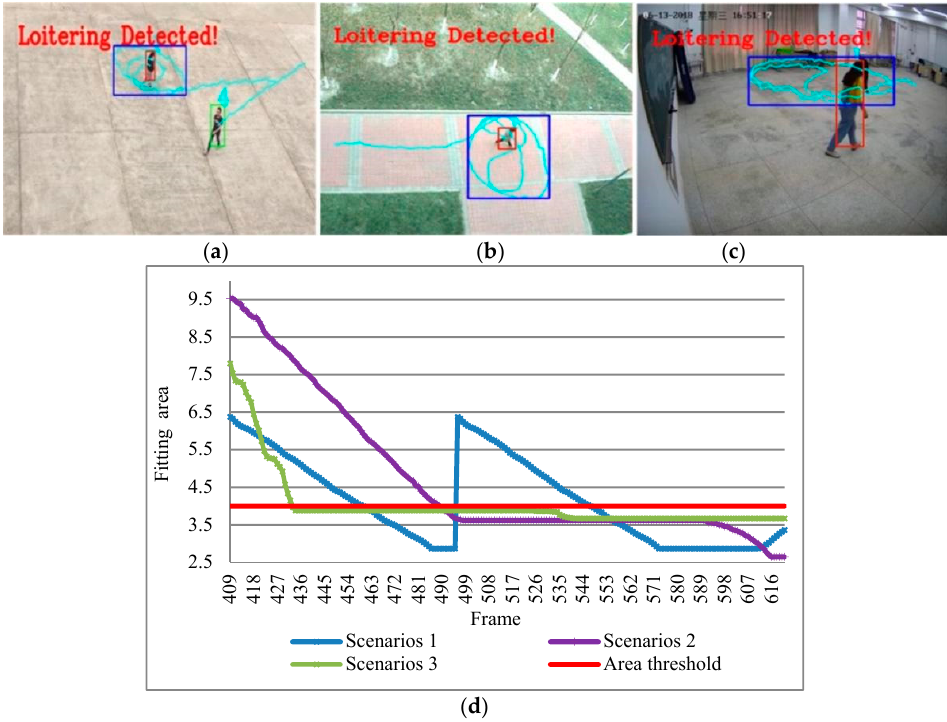
Figure 13. The result of rectangle loitering. ( a ) The rectangle loitering detection results of scenario 1. ( b ) The rectangle loitering detection results of scenario 2. ( c ) The rectangle loitering detection results of scenario 3. ( d ) The area fitting curve results of rectangle loitering, the red line in the figure indicates the threshold of the area.